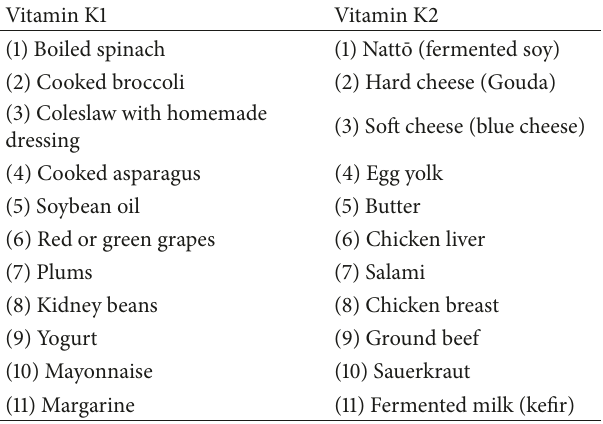
Table 2: Food sources of vitamins K1 and